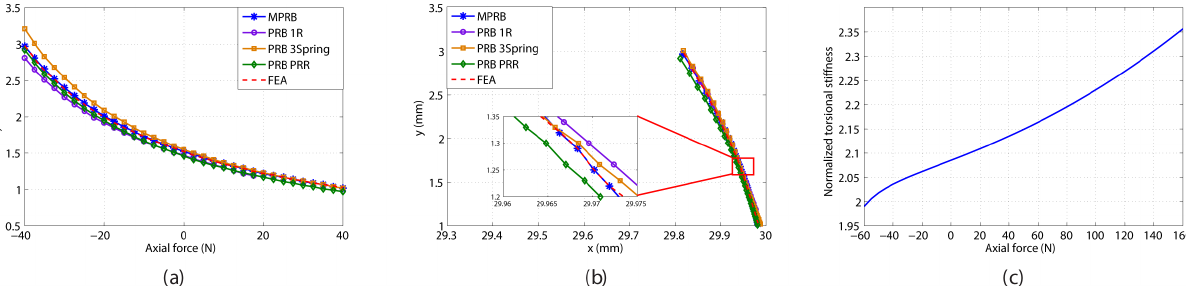
Figure 6. The deflection loci of the fixed-guided beam flexure with F = 5N. (a) Y -axial deflection. (b) Deflection loci of the guided end. (c) Normalized torsional